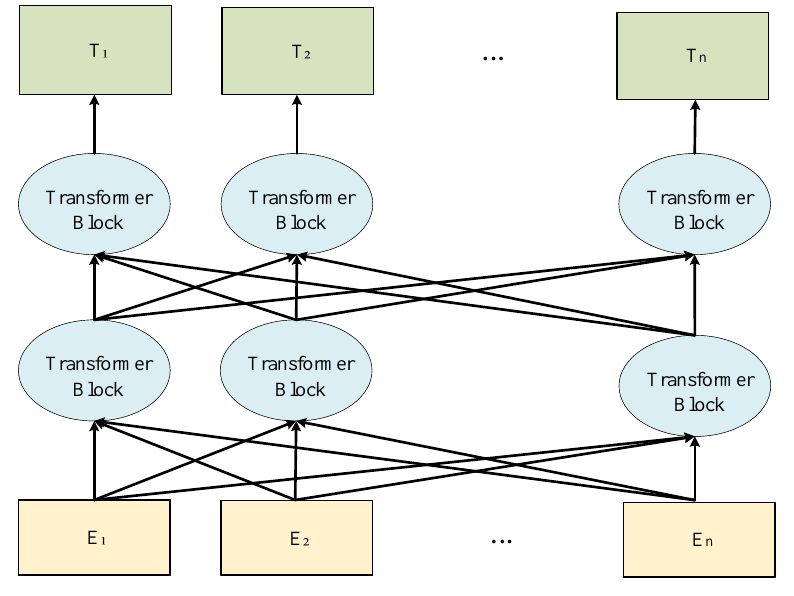
Figure 6. The overall structure of the BERT